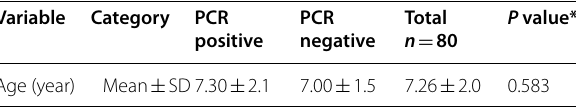
Table 4 The age distribution among study